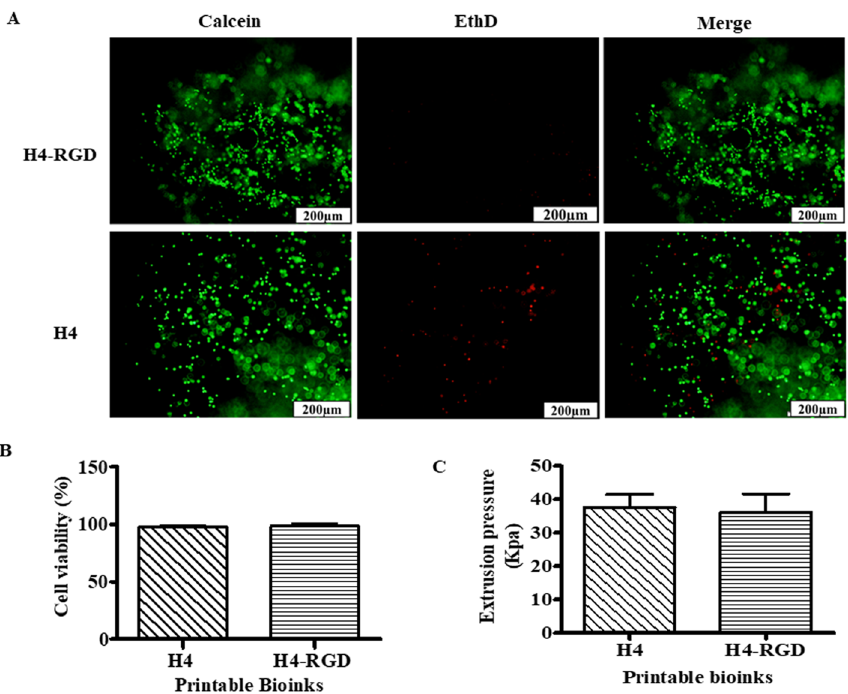
Figure 1. Ink-H4-RGD showing good extrudability and biocompatibility in MDA-MB-231 WT cells. ( A ) Live/ dead cell assay analysis using Calcein AM/Ethidium homodimer III staining. Results shown were